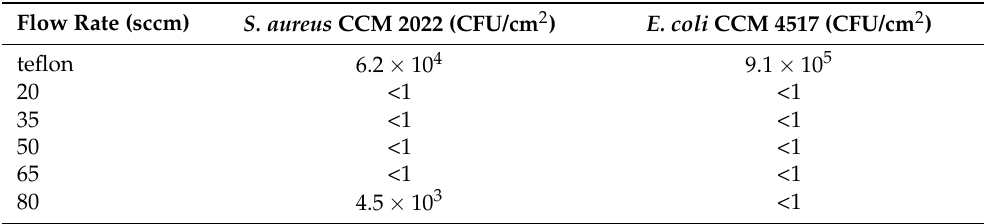
Table 3. Resulting numbers of surviving colonies (CFU/cm 2 ) on the PB films deposited at different monomer flow rates. Teflon marks bare substrate.